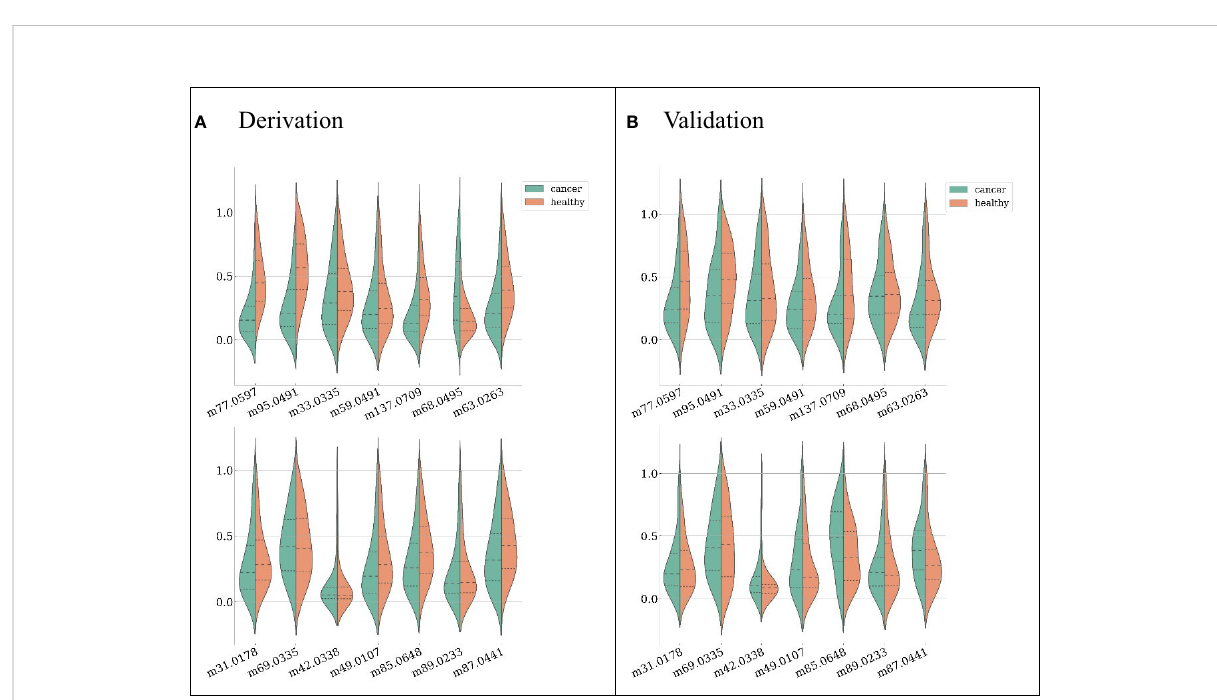
FIGURE 2 Feature distributions on the derivation dataset (A) and validation dataset (B) , ranked by their importance (the fi rst feature from left on the fi rst row is the most important). For each feature, both distributions from LC patients (green) and healthy subjects (red) are